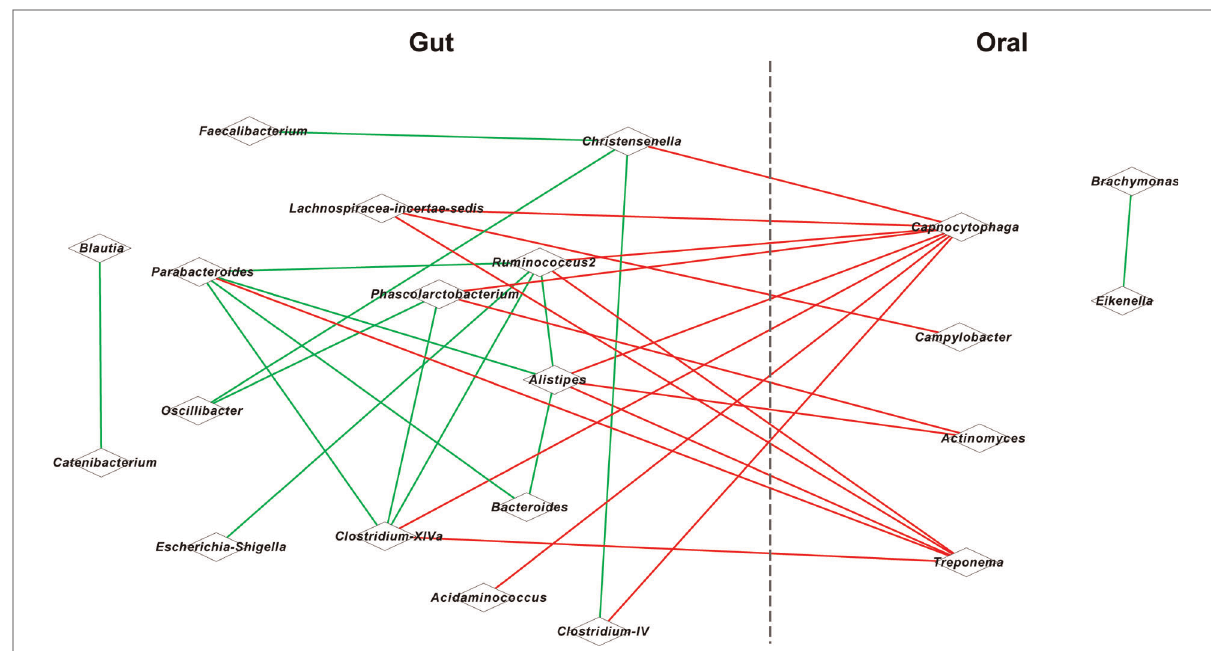
FIGURE 2 Co-occurrence network for oral and gut microbiota. Red lines represent a positive correlation, and blue lines represent a negative